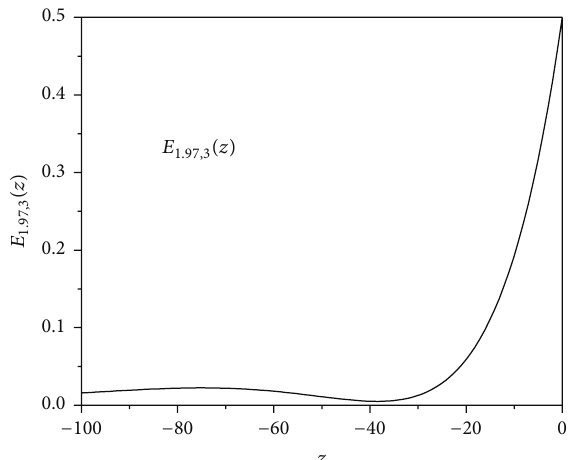
Figure 5: An ML function from phase [0/∞] 𝛼>1 displaying the oscillatory behaviour as 𝑧 → −𝑧